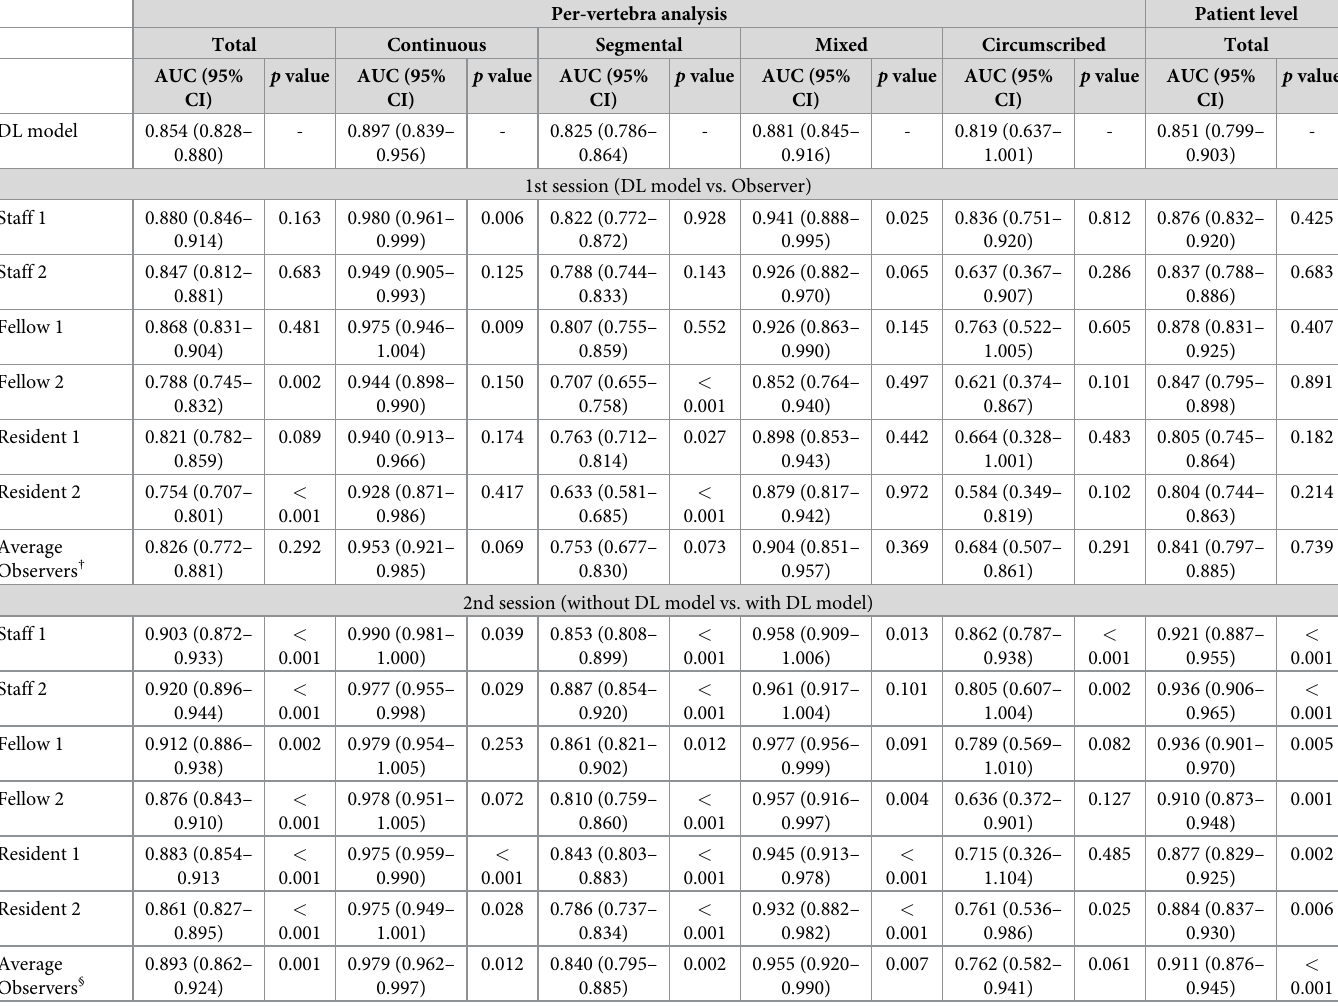
Table 2. Results of the observer performance test, including subgroup analysis, according to the morphologic subtype of